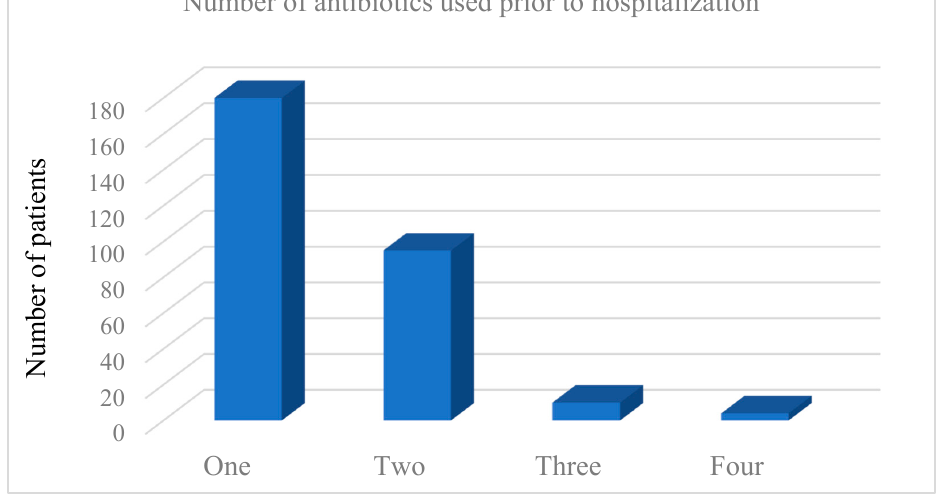
Figure 1. Number of antibiotics used prior to hospitalization.